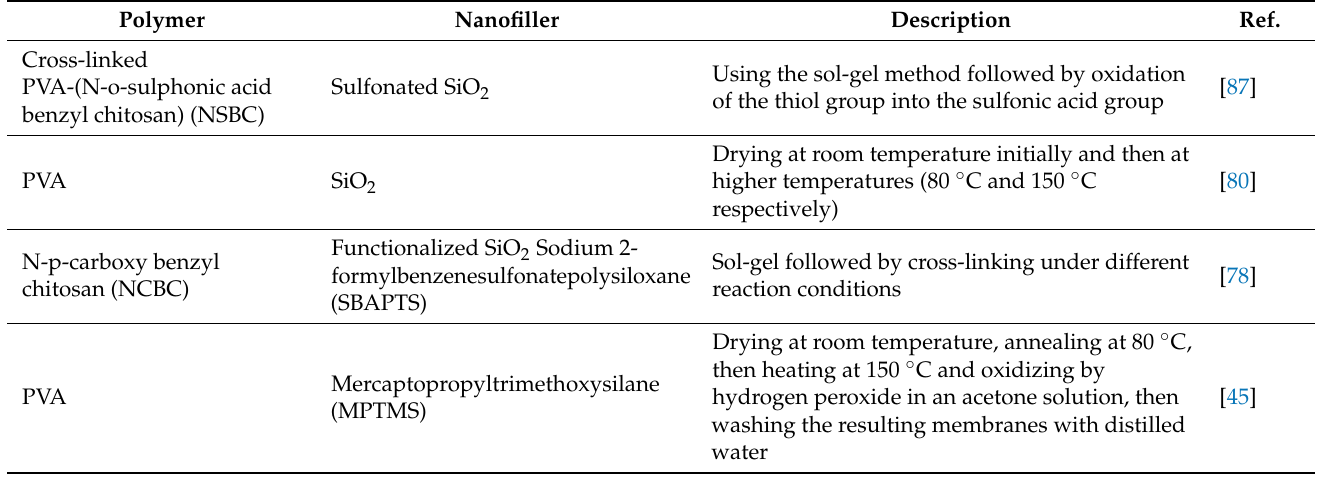
Table 4. PV nanocomposite membranes prepared using the sol-gel method reported in the